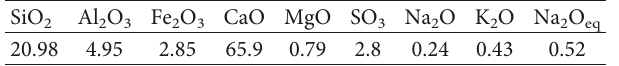
Table 1: Chemical analysis of